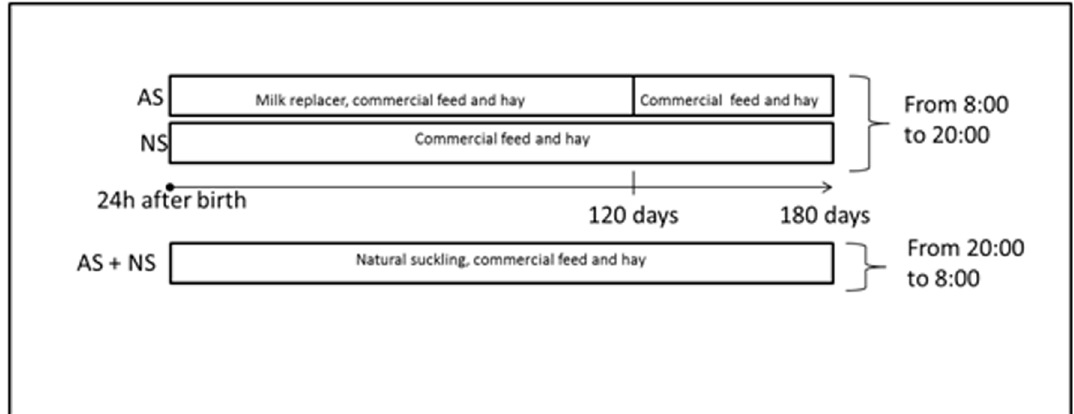
Fig 1. Experimental